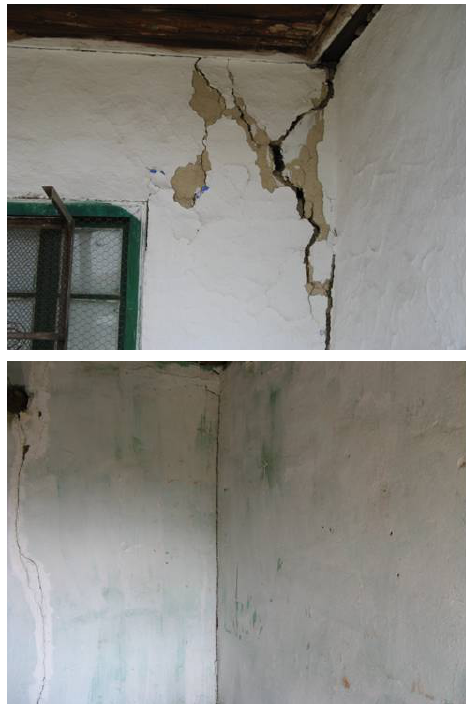
Fig. 17. Examples of openings between the structural walls. Fig. 17 Examples of openings between the structural walls